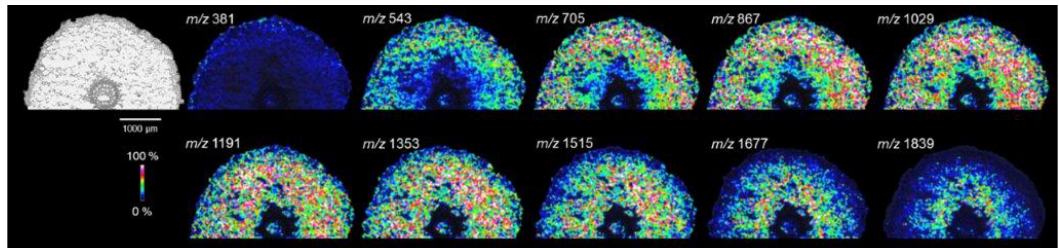
Figure 1. Oligosaccharide distribution patterns obtained by MALDI-MSI. Shown is a light microscopic image of a section together with the extracted ion intensity plots of the molecular ions [M + K] + for sucrose ( m/z 381) with a degree of polymerization (DP) of 2, as well as for oligosaccharides